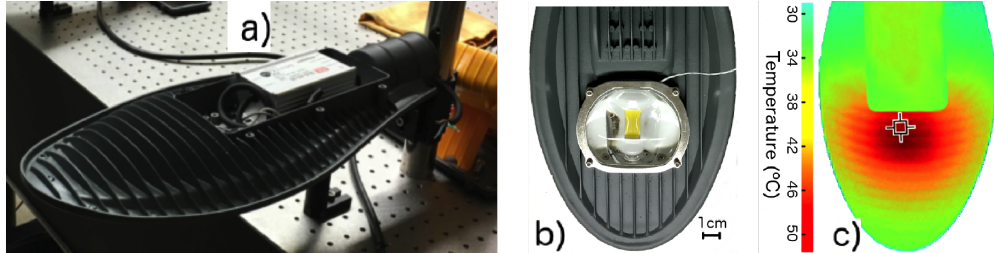
Figure 1. ( a ) A picture of the experimental setup in the laboratory. ( b ) Detail of the LED chip mounted at the bottom of the luminary. ( c ) A thermal image of the